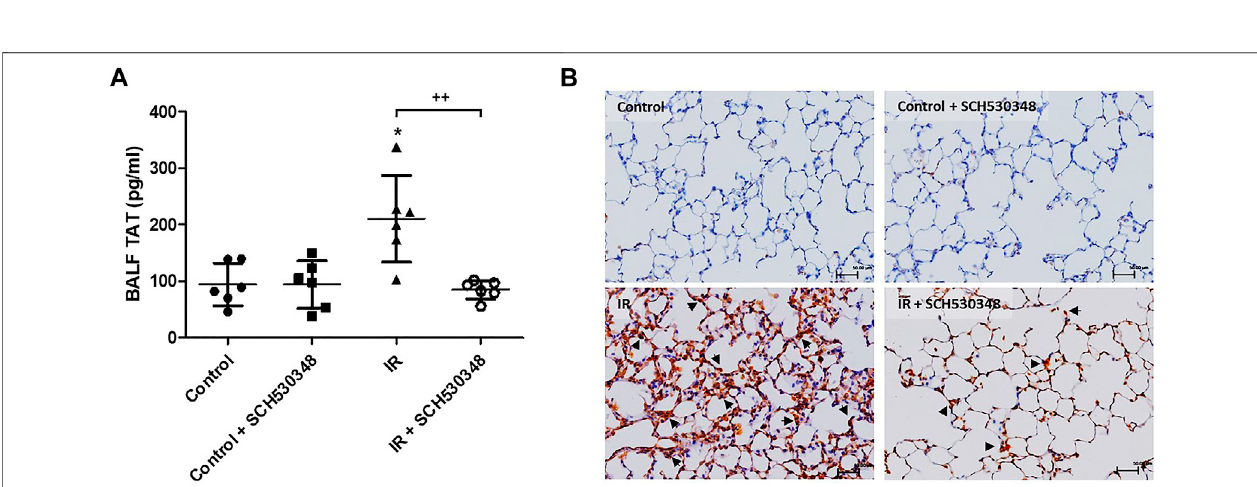
FIGURE 6 | SCH530348 downregulated IR-induced thrombin activity. (A) TAT levels in BALF were measured by ELISA. (B) Representative images showing IHC staining of thrombin in lung sections from the vehicle or IR group (200 × magni fi cation). Scale bars, 50 μ m. TAT levels in BALF and thrombin-positive cells in lung tissue (indicatedbyarrowheads)wereincreasedintheIRgroupcomparedwiththecontrolgroup.SCH530348treatmentmitigatedtheseincreases.Thedataareexpressedas the mean ± SD ( n (cid:1) 6 per group). * p < 0.05, compared with the control group; ++ p < 0.01, compared with the IR group.